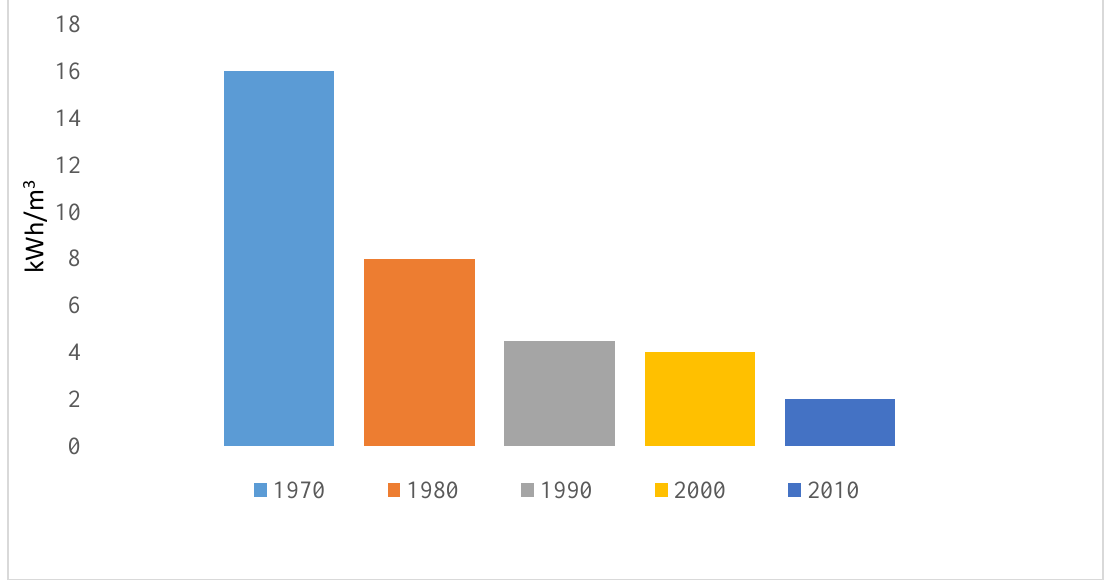
Figure 10. Trend in energy reduction in ED as reported by Sajjad et al. [21].